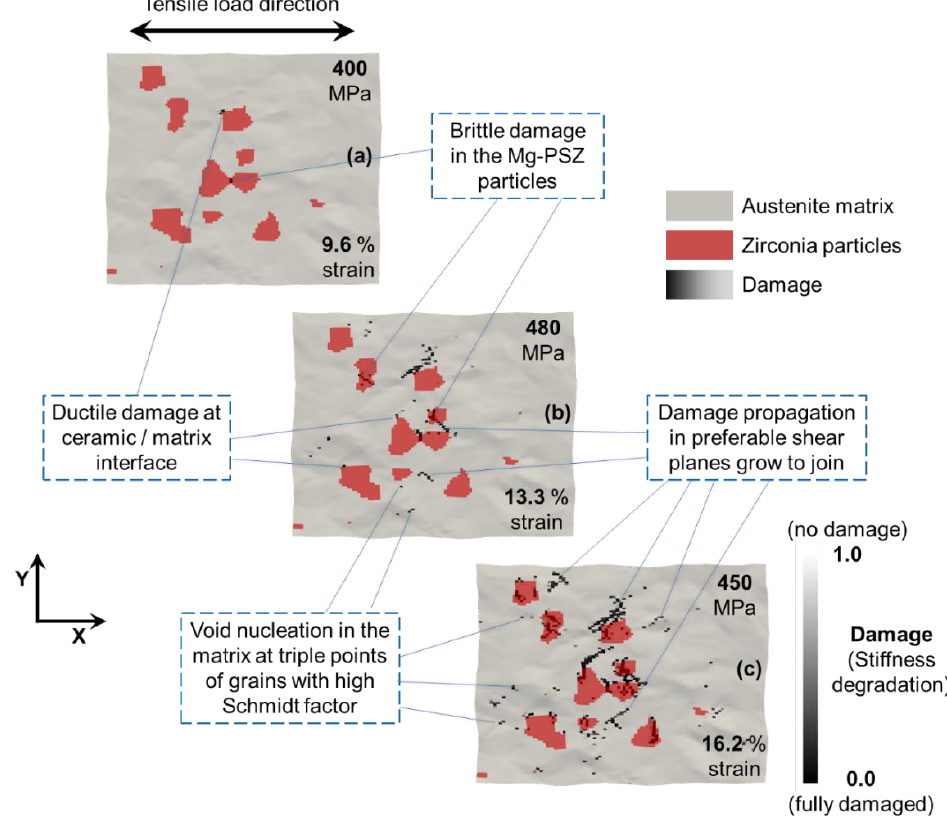
Figure 4. Visualization of local damage evolution on a phase distribution map at ( a ) 9.6% strain, ( b ) 13.3% strain, and ( c ) 16.2% strain. The zirconia particles have been made semitransparent to show the damage initiation and evolution in both phases. Light grey is not damaged, whereas the back color represents a fully damaged solution point with no stiffness.